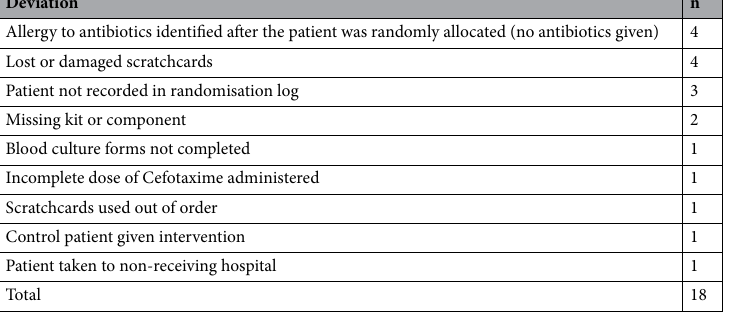
Table 2. Protocol